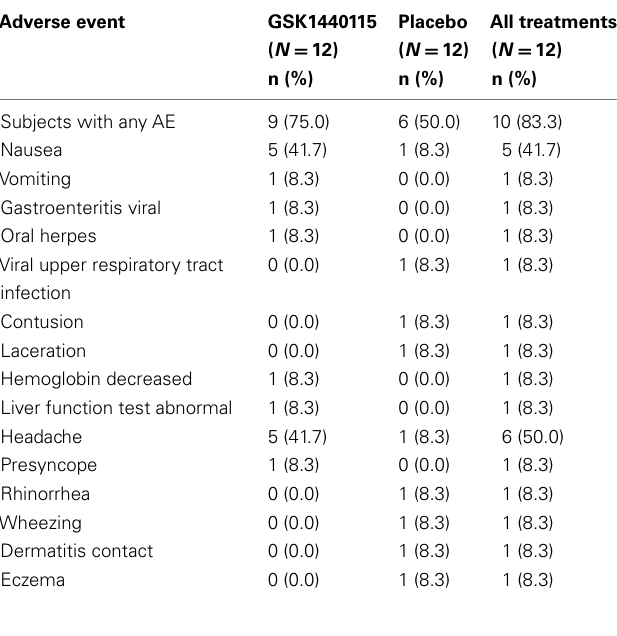
Table 3 | Summary of adverse events – phase Ib study in asthmatic subjects.